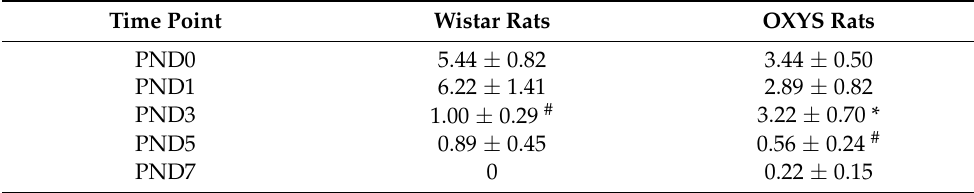
Table 3. The number of radial glial cells’ processes in the PFC of OXYS and Wistar rats (counts per field of